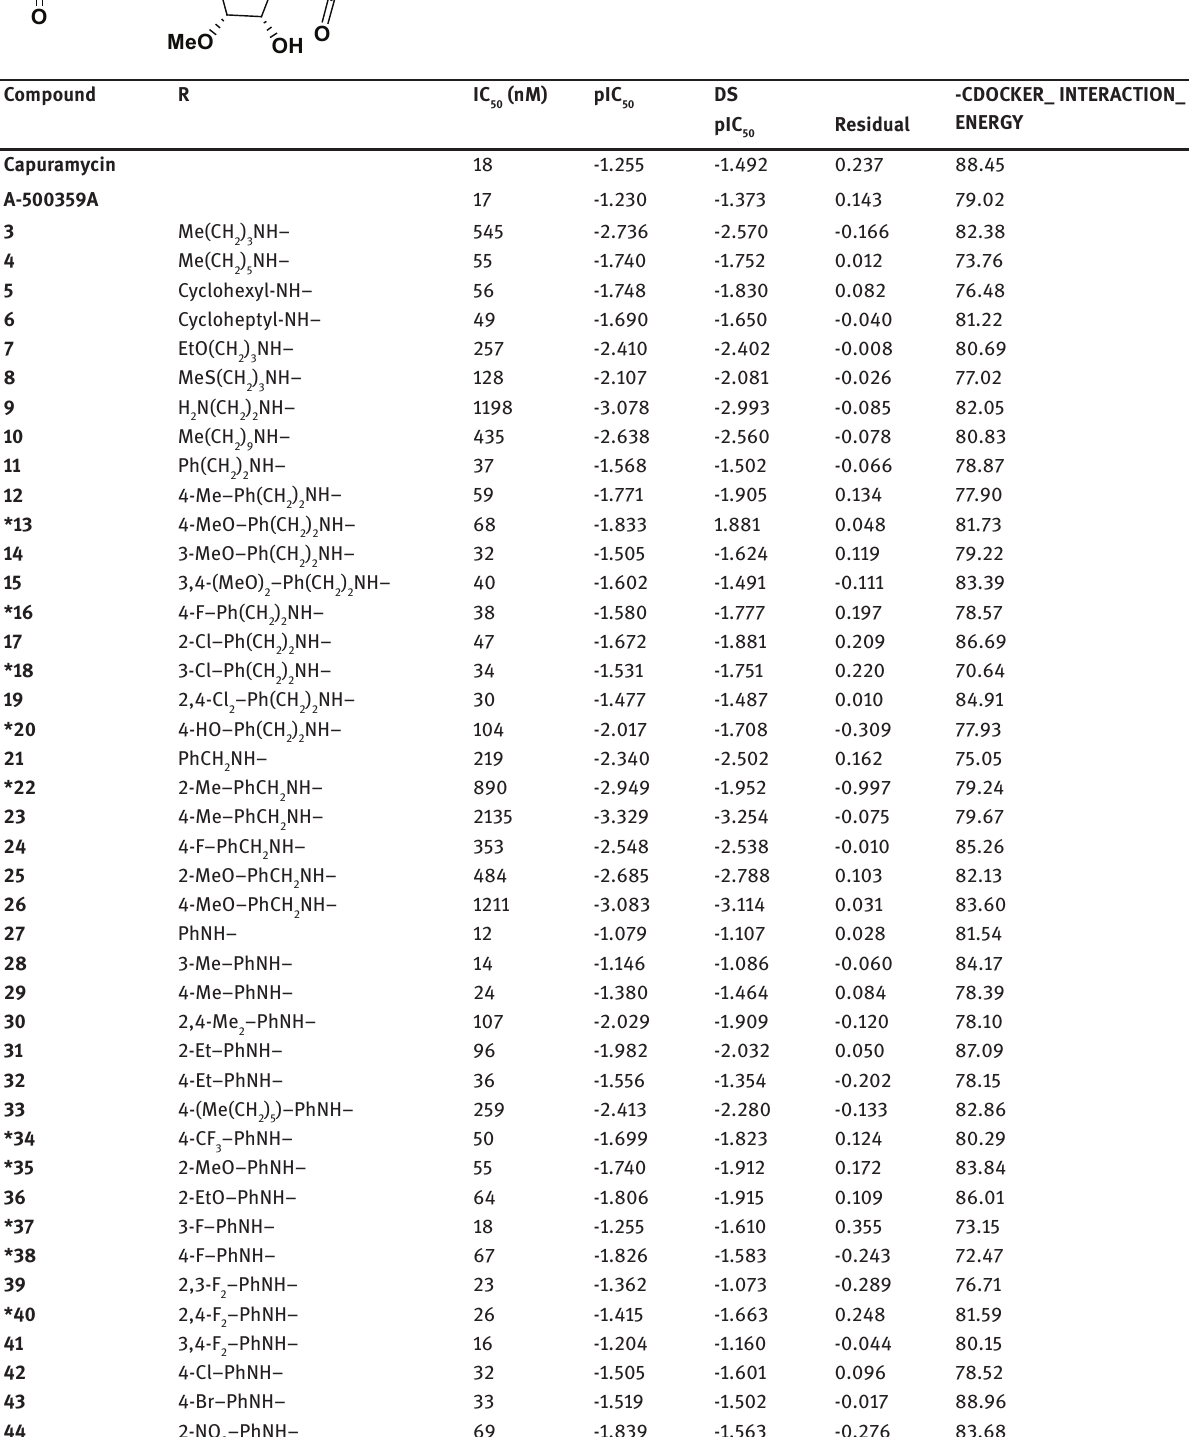
Table 1: Experimental and 3D-QSAR predicted MraY inhibition activities of capuramycin derivatives.